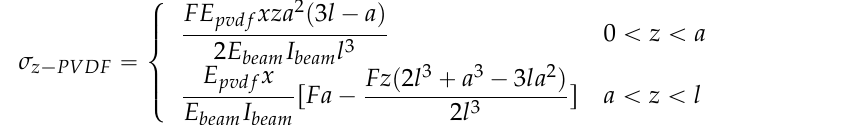
Figure 6. Electrical circuit of the sensor.